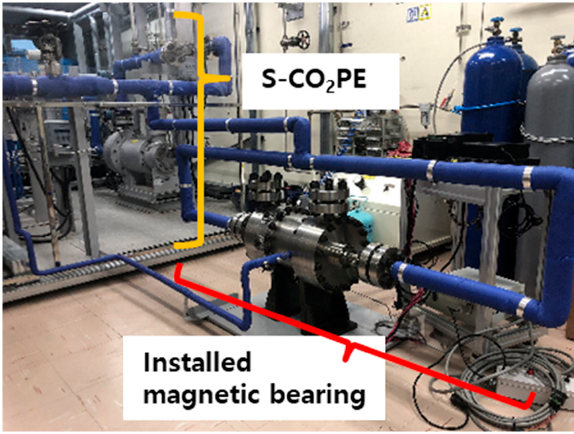
Figure 13. AMB and the compressor system for S-CO 2 .